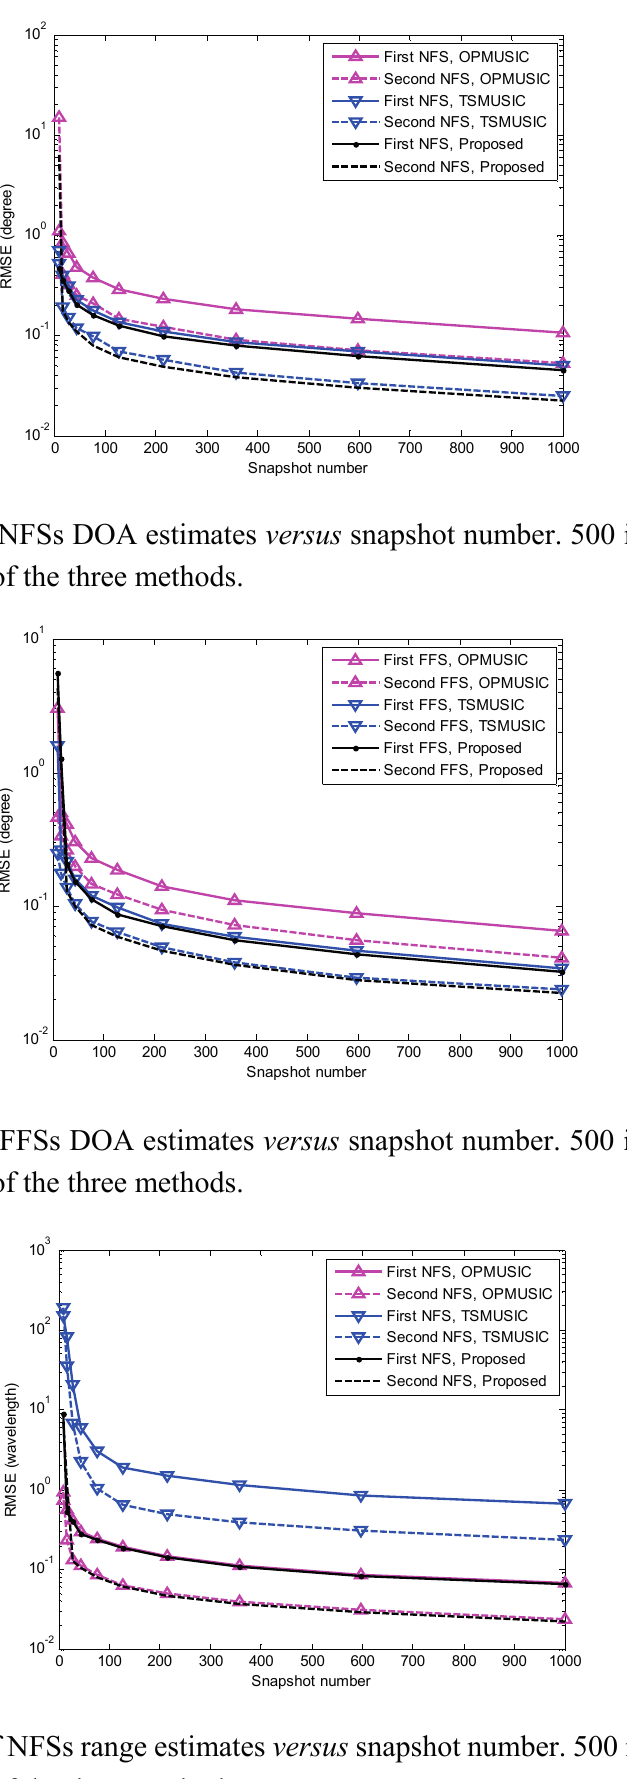
Figure 10. RMSEs of NFSs range estimates versus snapshot number. 500 independent trials are realized for each of the three